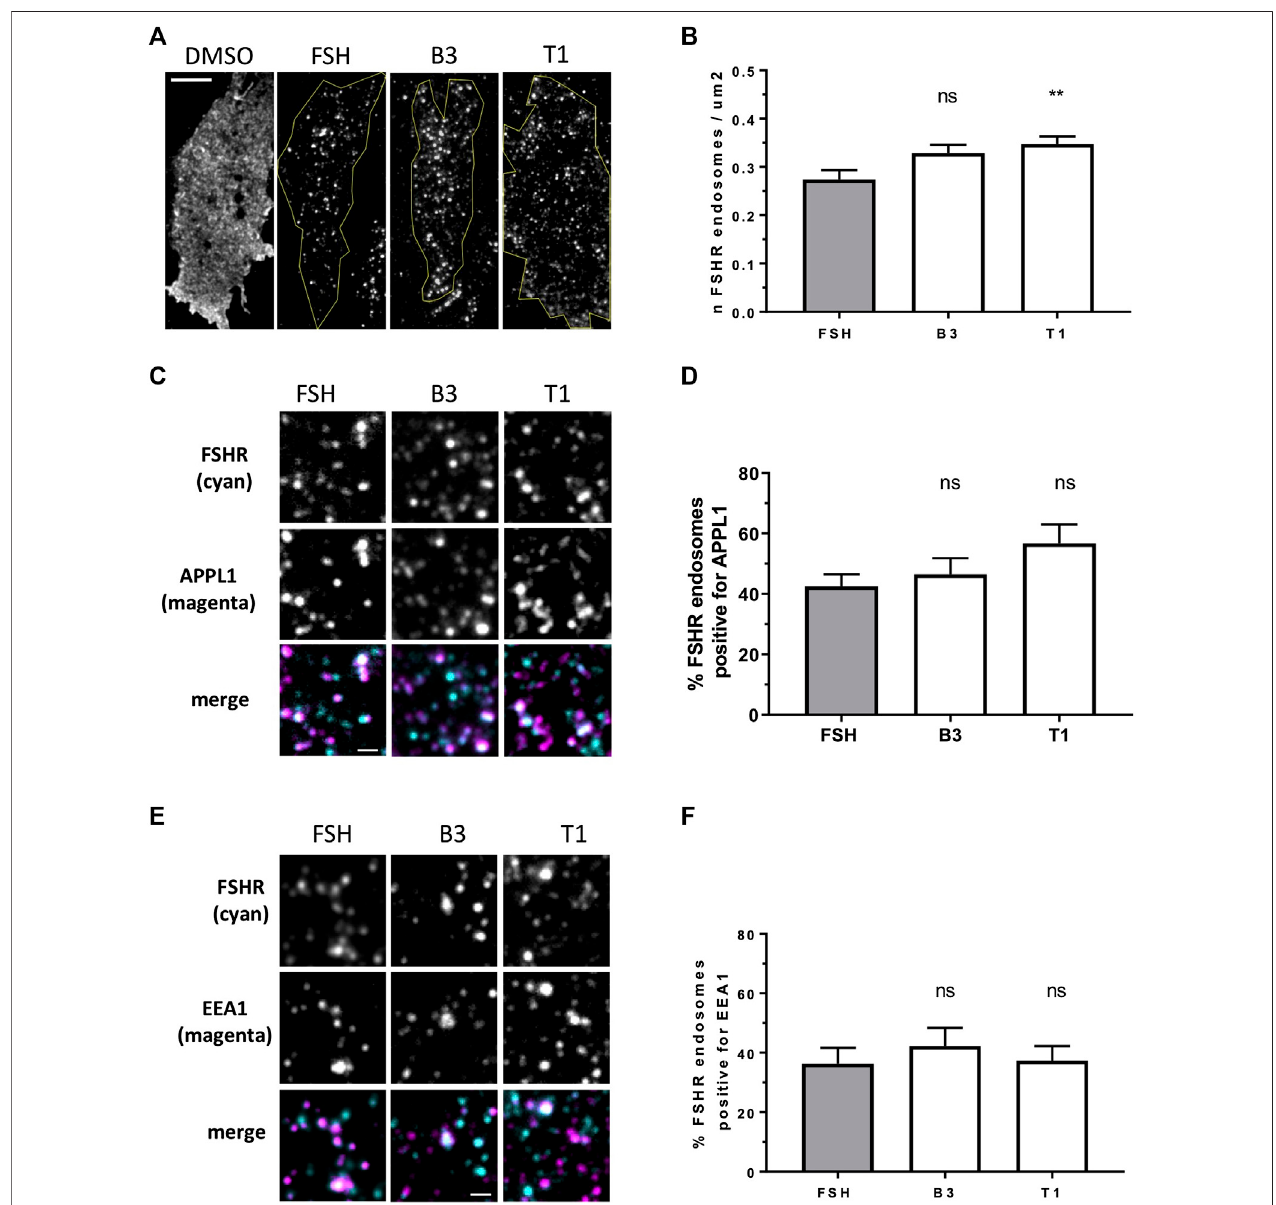
FIGURE 2 | LMW agonists do not alter the endosomal organization of FSHR (A) Representative TIR-FM images of FLAG-FSHR expressing HEK 293 cells treated witheitherDMSO,FSH(10 nM),B3orT1(10 μ M)for5 min.Scalebar (cid:2) 10 μ m. (B) Quanti fi cationofFSHRendosomesinstimulatedcellsfrom (A) ;n (cid:2) 24cells/condition collected across three independent experiments. One-way ANOVA: ** p < 0.01. (C) TIR-FM images of FLAG-FSHR (cyan) and endogenous APPL1 (magenta) in cells stimulated with either FSH (10 nM), B3 or T1 (10 μ M) for 5 min. Scale bar (cid:2) 1 μ m. (D) Quanti fi cation of FSHR endosomes positive for APPL1 from (C) ; n (cid:2) 10 – 12 cells/condition collectedacrossthree independent experiments. (E) TIR-FM images ofFSHR(cyan) andendogenousEEA1 (magenta) incells stimulated witheither FSH (10 nM),B3orT1(10 μ M)for5 min.Scalebar (cid:2) 1 μ m. (F) Quanti fi cationofFSHRendosomespositiveforEEA1from (E) ;n (cid:2) 11 – 12cells/conditioncollectedacrossthree independent